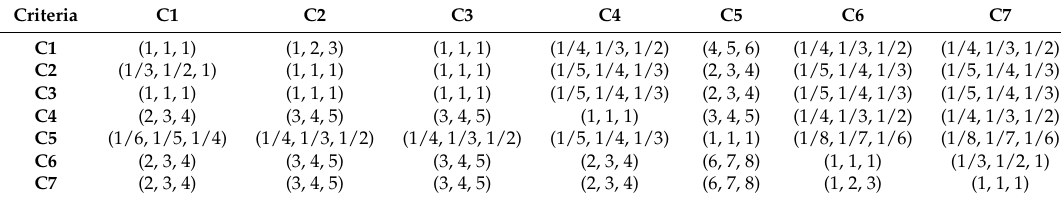
Table 4. Fuzzy Comparisons for each criteria (Expert 2).